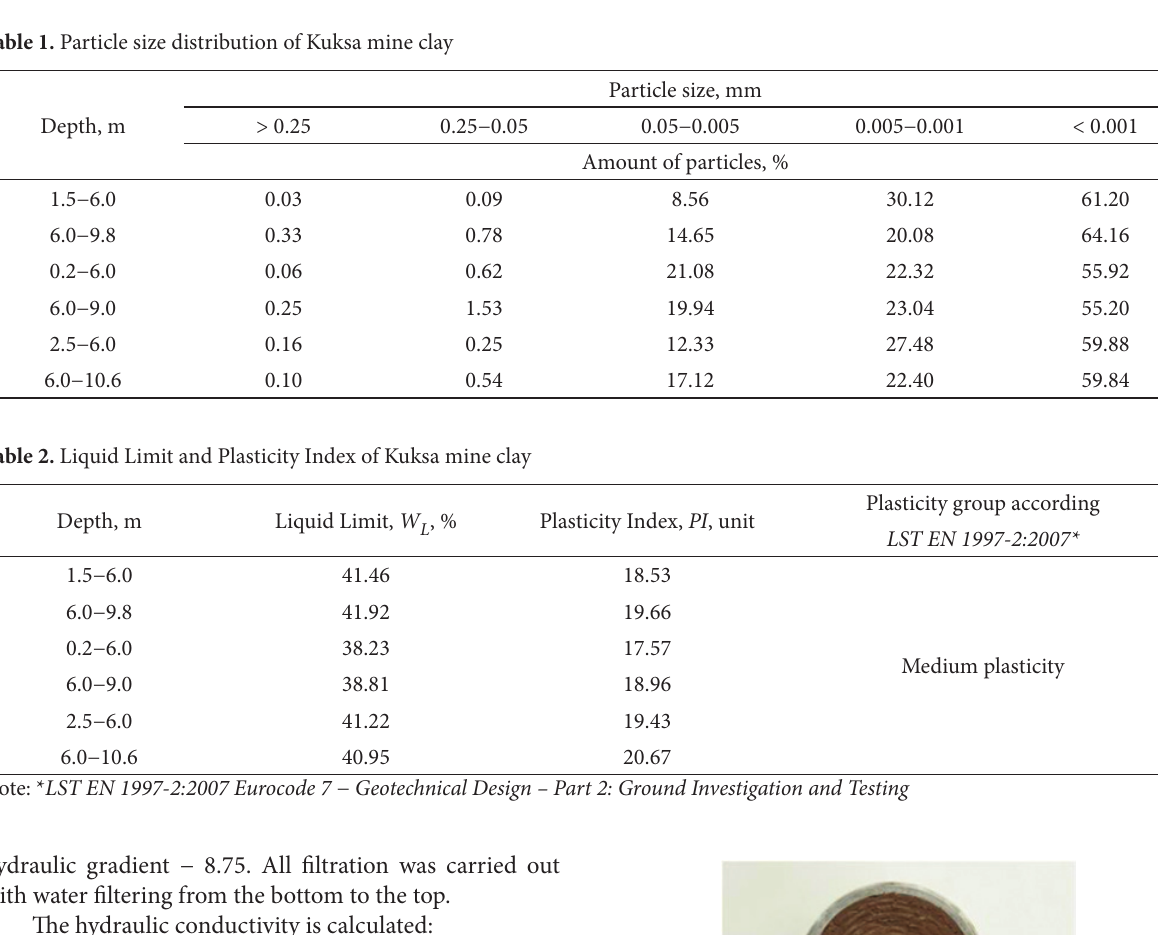
Table 1. Particle size distribution of Kuksa mine clay